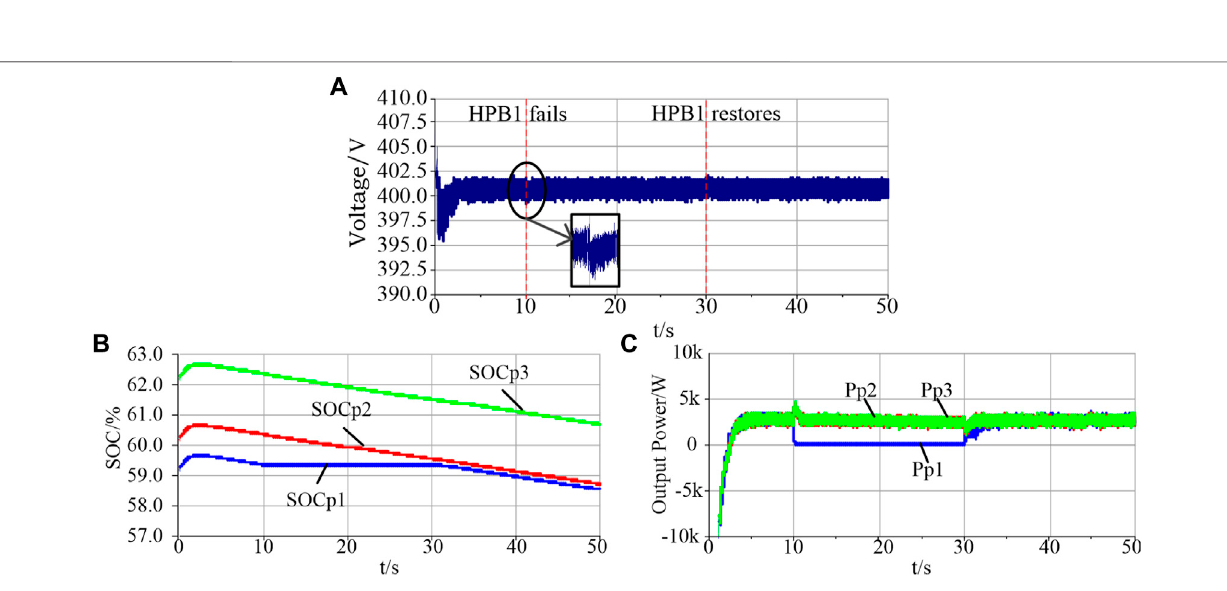
Frontiers in Energy Research |